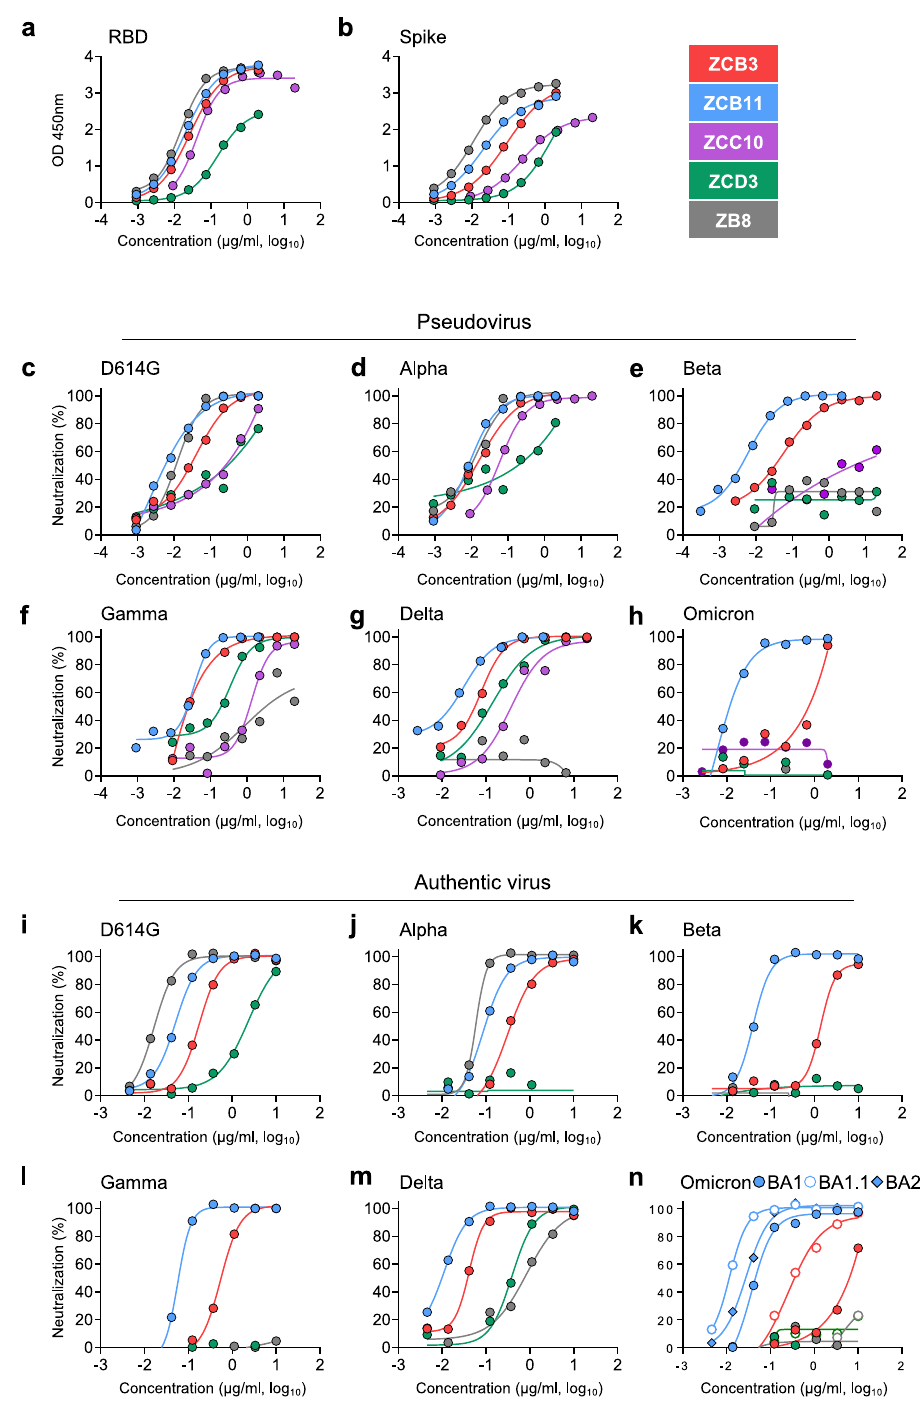
Fig. 2 Comparison of bNAbs isolated from the BNT162b2-26 vaccinee. a , b RBD- and spike-speci fi c binding activities of four newly cloned NAbs including ZCB3, ZCB11, ZCC10, and ZCD3 were determined by ELISA at serial dilutions. A known NAb ZB8 was included as a control. c – h Neutralizing activities of ZCB3, ZCB11, ZCC10, and ZCD3 were determined against six pseudotyped SARS-CoV-2 variants, including D614G (WT), Alpha, Beta, Gamma, Delta, and Omicron as compared with ZB8. i – n Neutralizing activities of ZCB3, ZCB11, ZCC10, and ZCD3 were determined against the same but authentic SARS-CoV- 2 variants, including Omicron BA.1, BA.1.1, and BA.2 as compared with ZB8. The color coding was consistently used in a – n . The dashed line in each graph indicated 50% neutralization. The experiments were performed in at least duplicates. Source data are provided as a Source Data fi le. RBD receptor-binding domain, ELISA enzyme-linked immunosorbent assay, bNAbs broadly neutralizing antibodies, WT